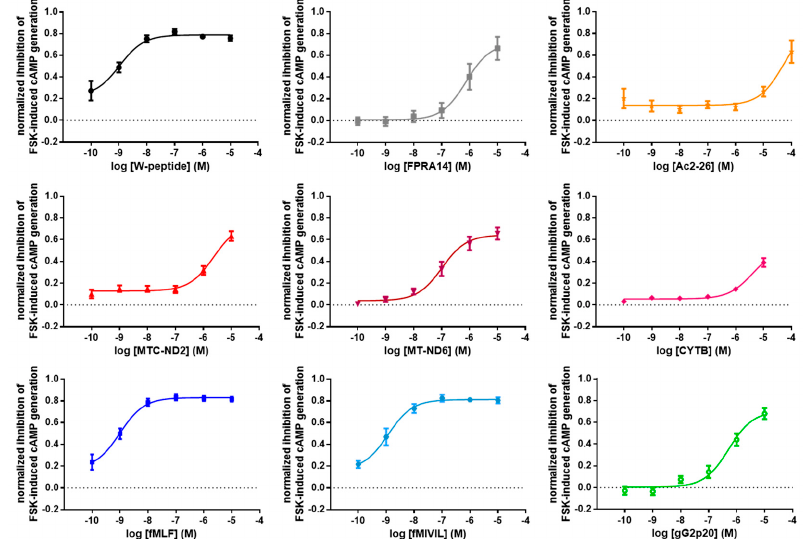
Figure 2. Concentration–response curves for FPR1-mediated inhibition of cAMP production. Cells were stimulated with forskolin (FSK) and the respective FPR1 agonists. Responses recorded 30 min after agonist addition were normalized to the maximum system response obtained with forskolin. Data points represent the mean ± SEM of at least 7 independent